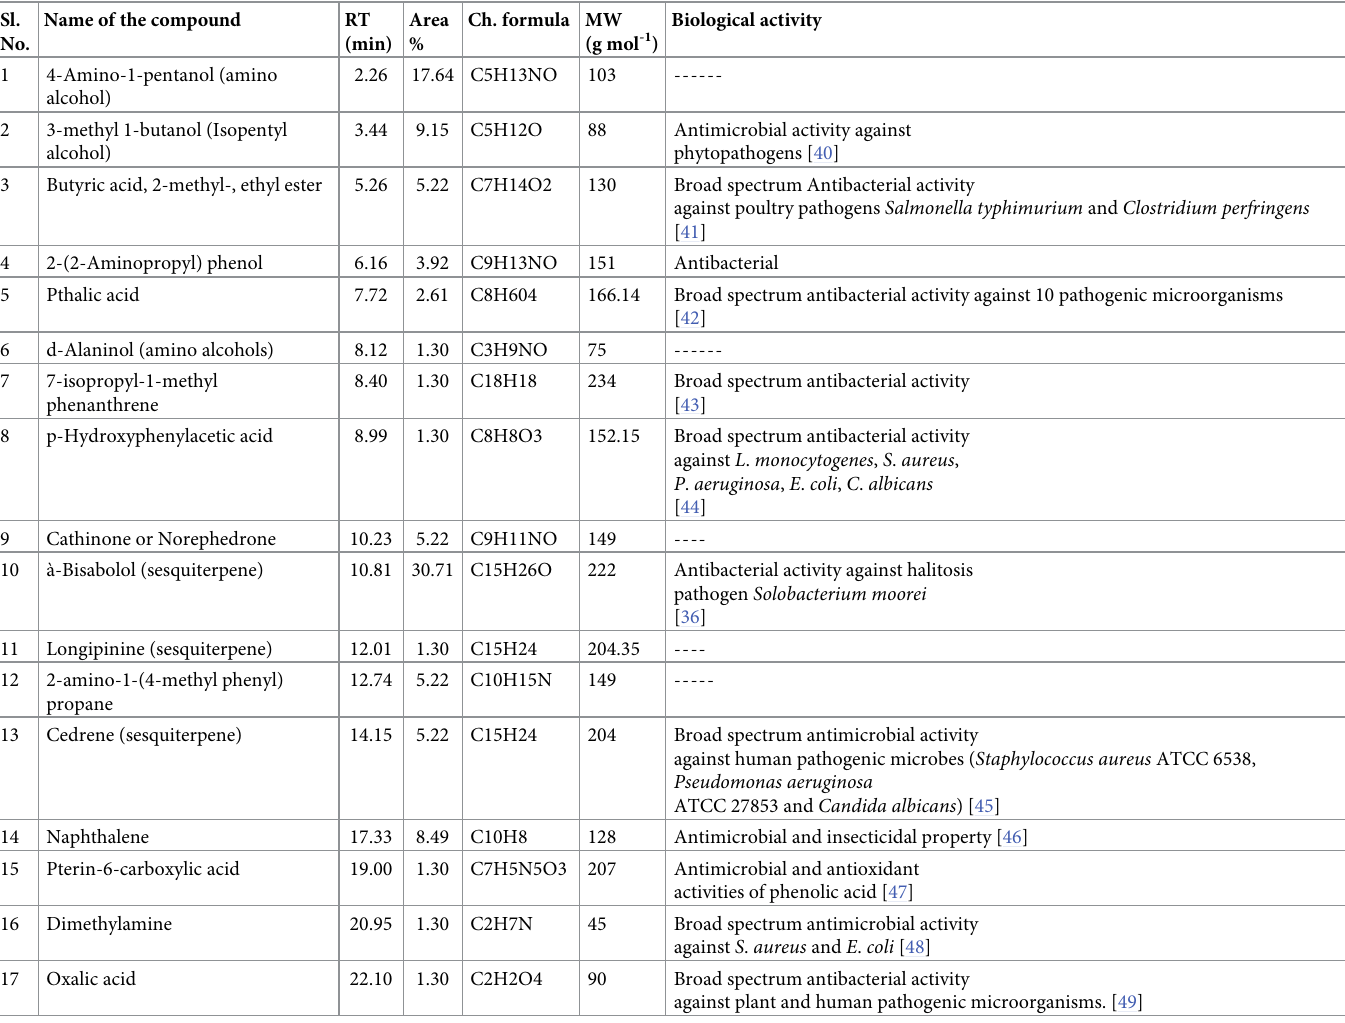
Table 6. List of bioactive compounds produced by Colletotrichum alatae LCS1and their respective bioactivities. Sl. Name of the No.